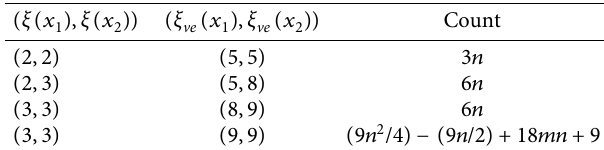
( n, n ) . m ( n, n ) junction m